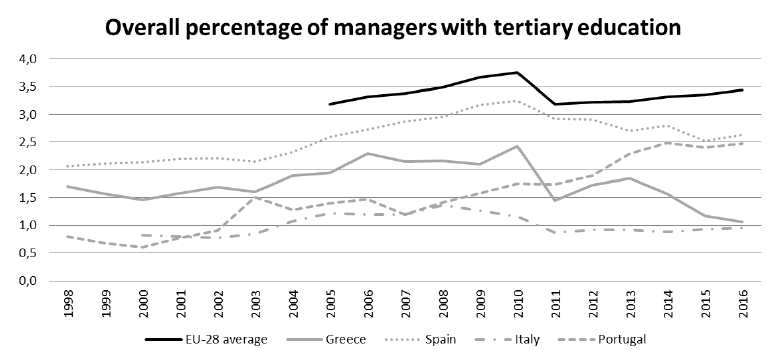
Figure 4: Overall percentage of managers with tertiary education among employed population